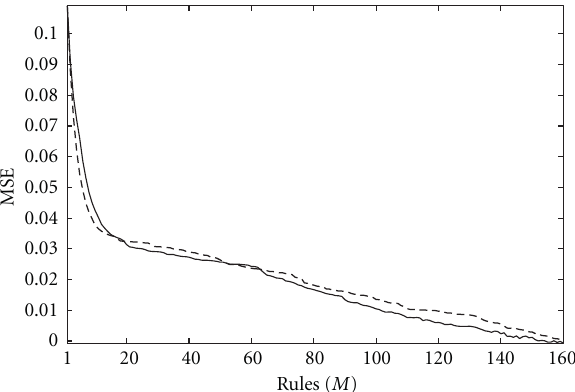
Figure 12: Convergence of the HCS algorithm: single execution in HHCS (continuous line); best execution in OHCS (dashed